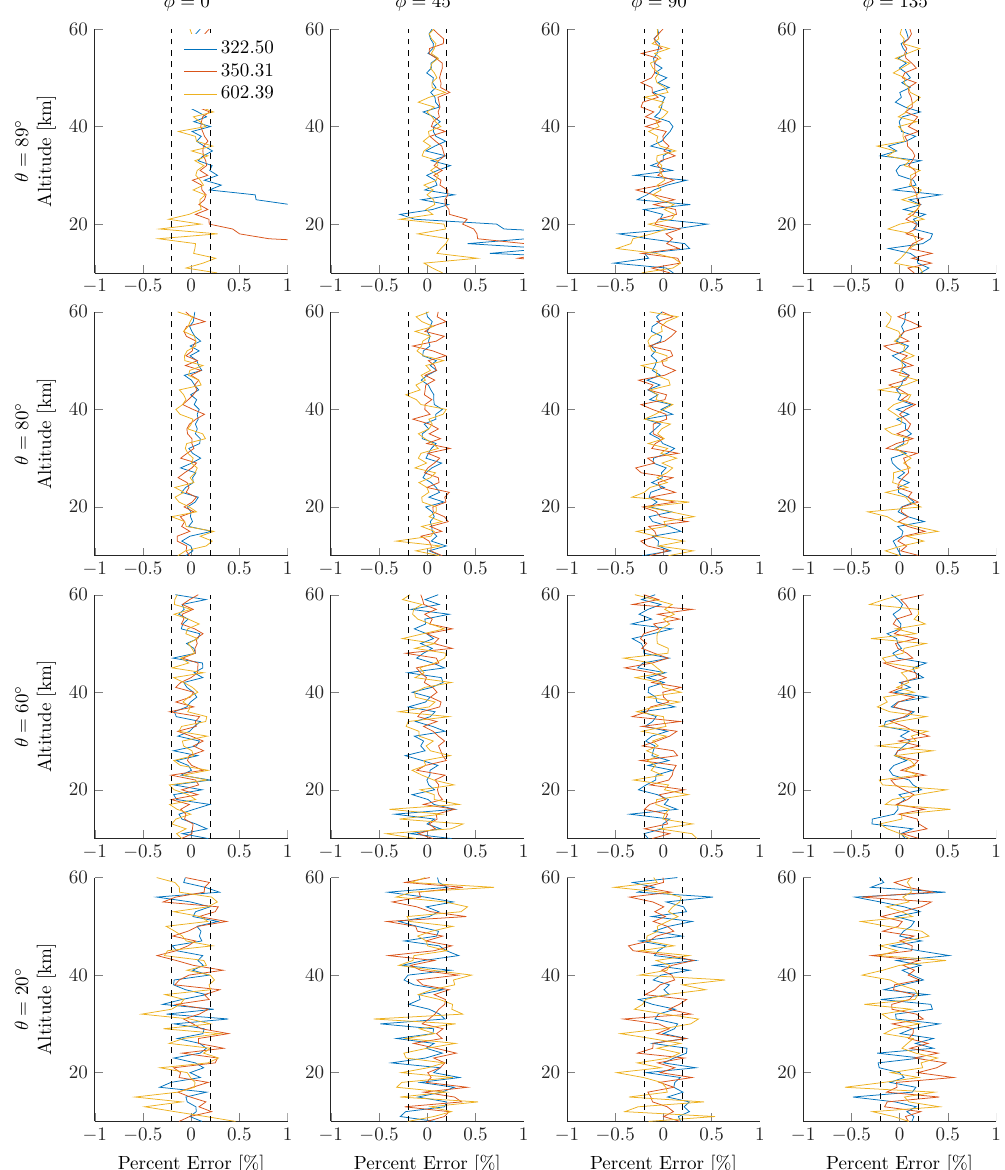
Figure 4. Percent difference in simulated radiance between HR and MC ( ( HR − MC )/ MC · 100%) as a function of altitude at select solar zenith angles, θ , and solar azimuth angles φ . Dashed vertical lines indicate the estimated SD of the Monte Carlo results. HR was run with 11 diffuse